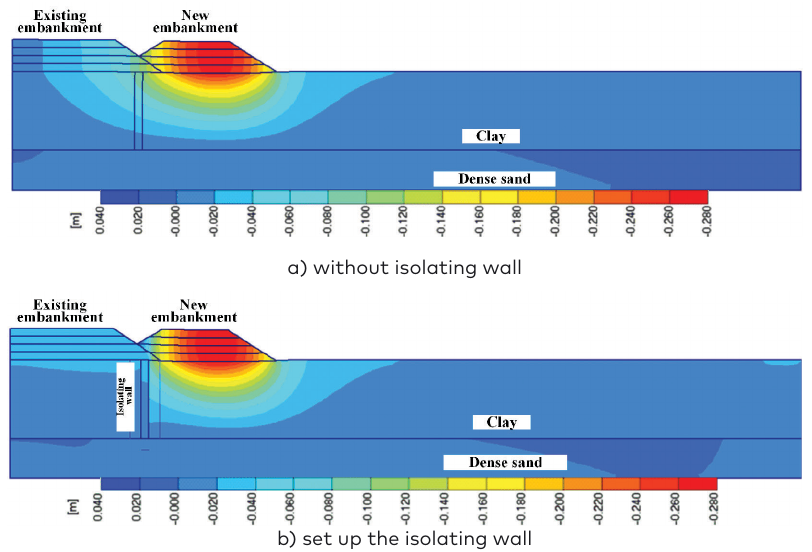
b) set up the Figure 5. Vertical displacement distribution after 15 years of embankment widening